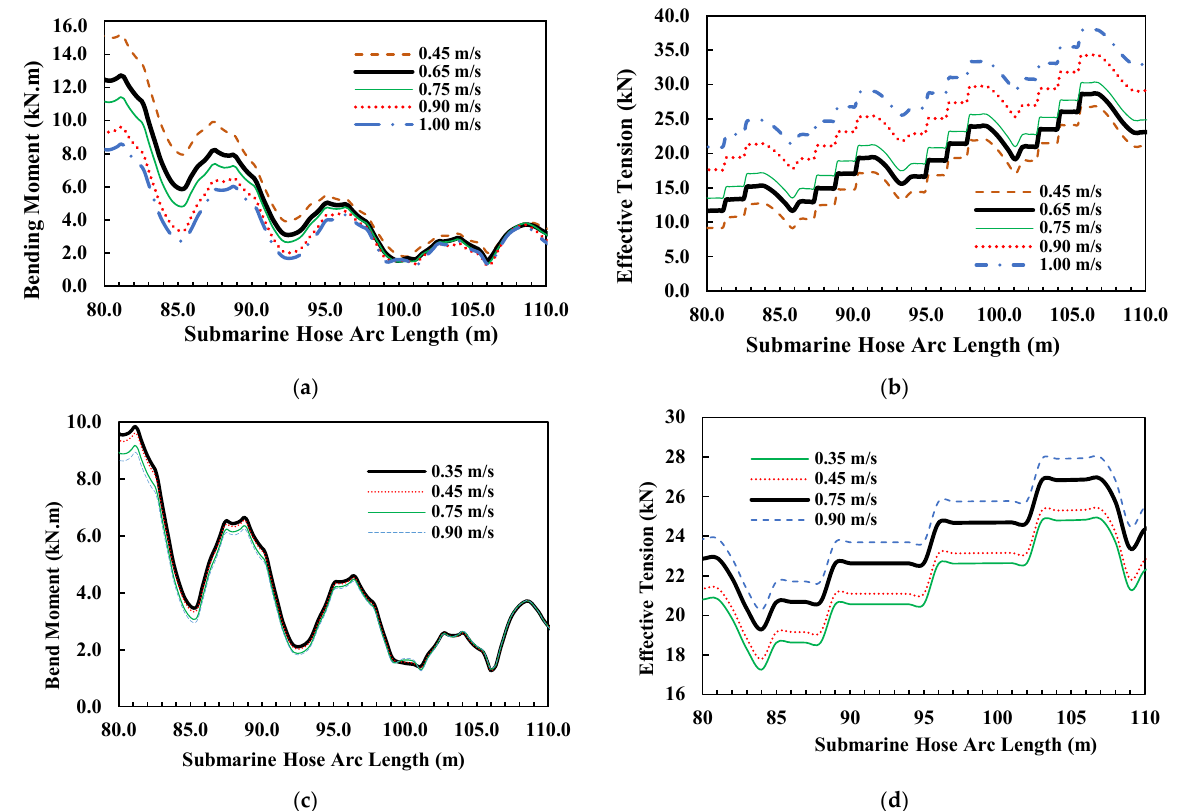
Figure 27. Result of surface currents ( a , b ) and seabed currents ( c , d ) on submarine hoses. ( a ) Bending Moment for surface current on arc lengths. ( b ) Effective tension for surface current on arc lengths. ( c ) Bending Moment for seabed current on arc lengths. ( d ) Effective tension for seabed current on arc lengths.